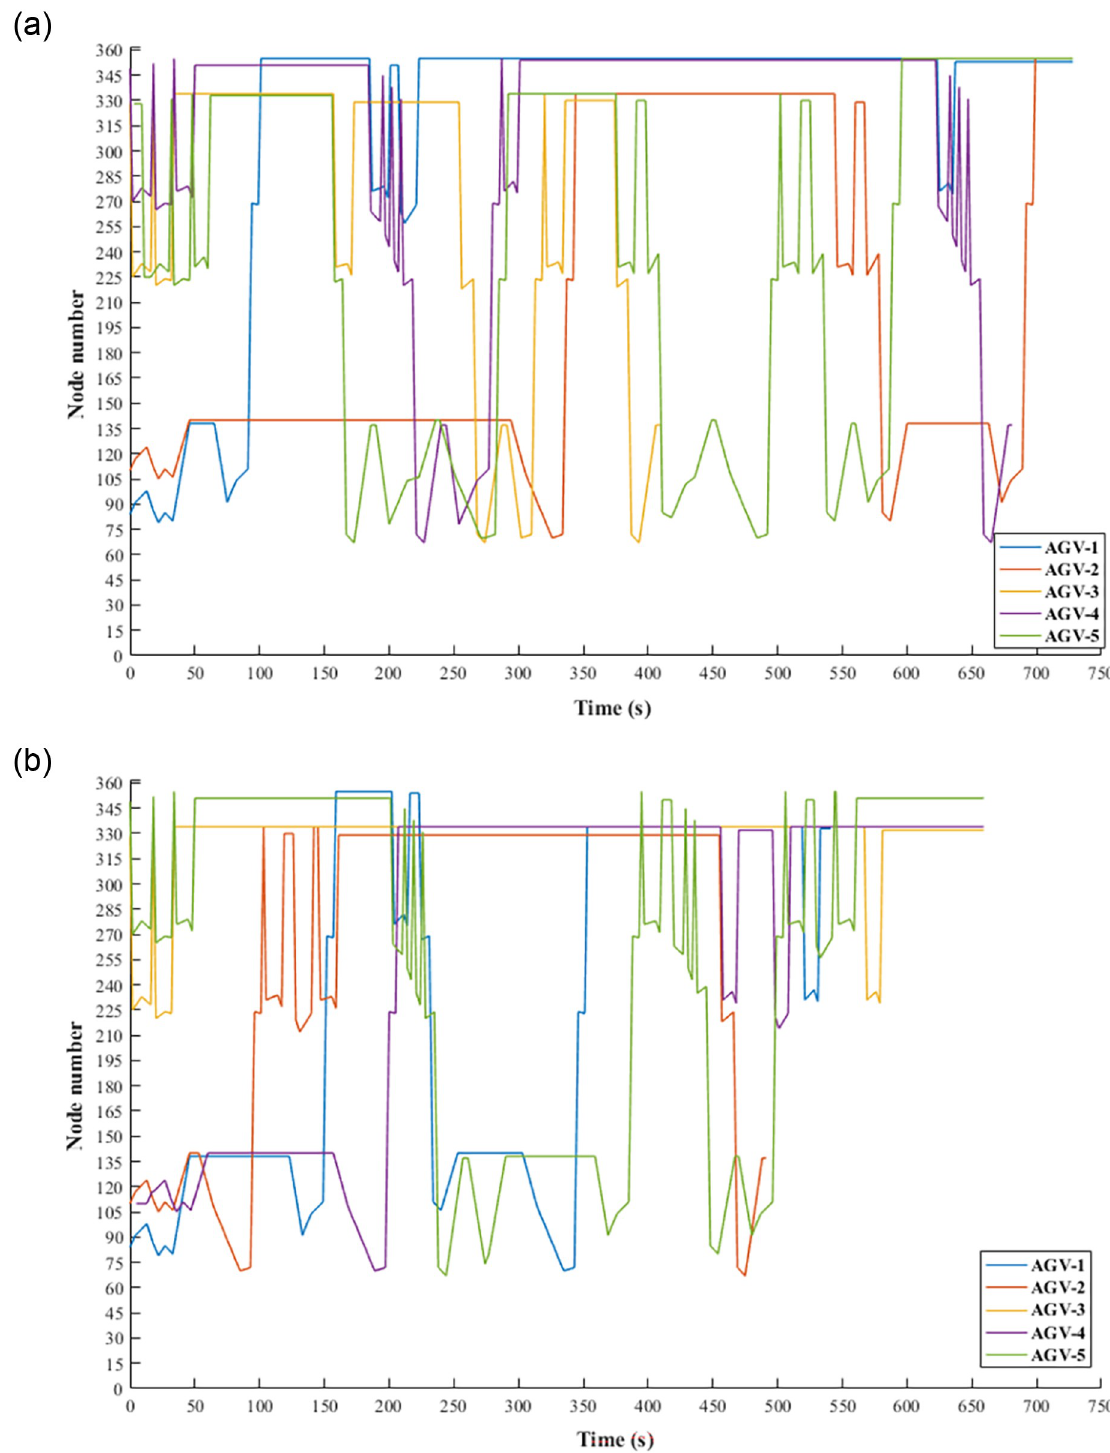
Fig 16. Detailed routing results of the CRRC-BGA and the CRRC-BHGTSA for the 14 th experiment. (a) represents the detailed routing result of the CRRC-BGA; (b) represents the detailed routing result of the CRRC-BHGTSA.